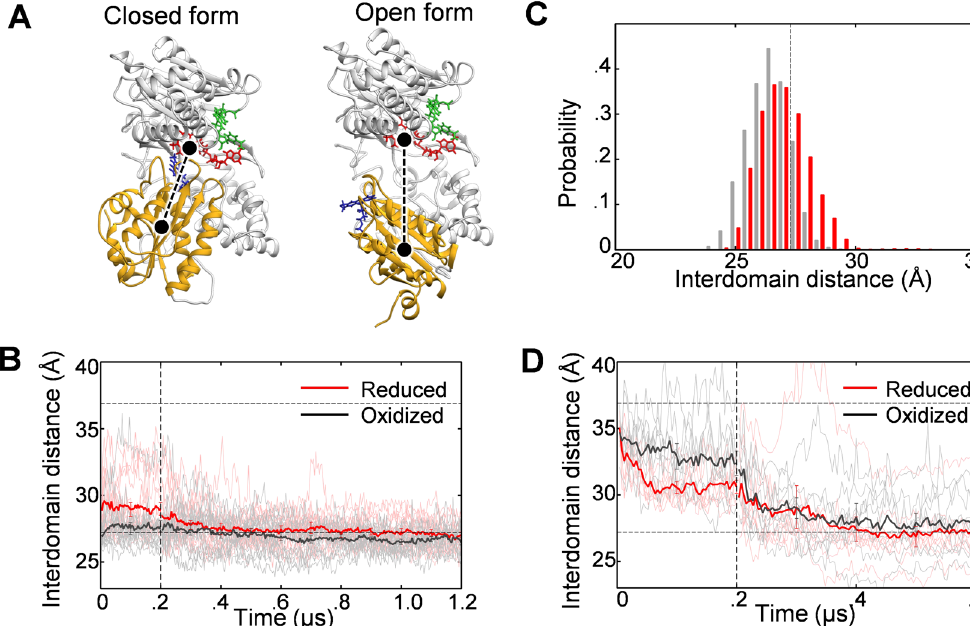
Figure 1. Redox-state dependence of FAD-FMN interdomain distance. ( A ) Crystal structures in the closed form 7 and the open form 8 ; FAD domain (including the connecting domain): gray, FMN domain: yellow, FAD (cofactor): red, FMN (cofactor): blue, and NADP + : green. Black circle indicates the center of mass of each domain. ( B ) Average time course of the interdomain distance, starting from the closed form [0–0.2 μ s: cMD, 0.2–1.2 μ s: aMD; 16 individual time courses are also shown (oxidized: gray, reduced: pink)]. Horizontal lines indicate the values for the crystal structures. ( C ) Probability distributions of the interdomain distance for the oxidized (gray) and reduced (red) states calculated using reweighted data for the last 0.5 μ s (see Methods for the reweighting). ( D ) Average time course of the interdomain distance, starting from the open form [0–0.2 μ s: cMD, 0.2–0.6 μ s: aMD; 8 individual time courses are also shown (oxidized: gray, reduced: